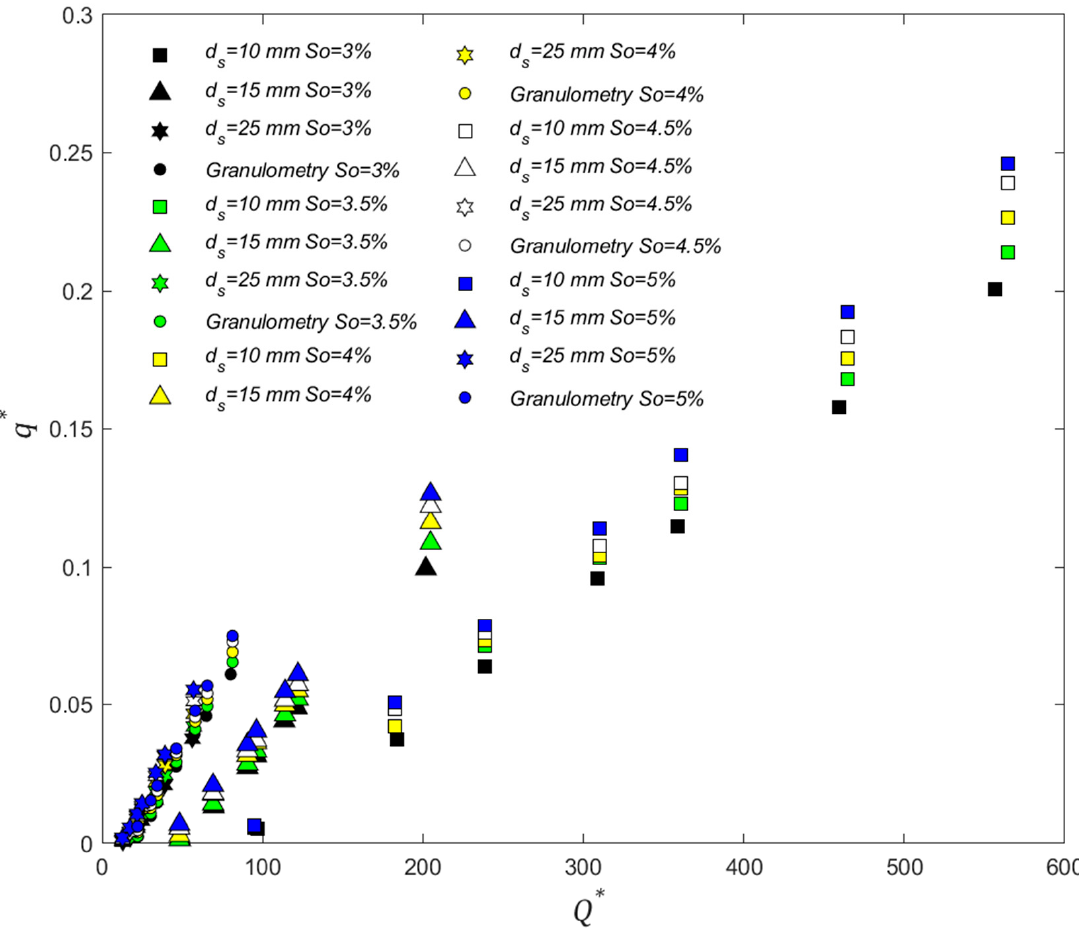
Figure 8. Variation of dimensionless transport rates with dimensionless discharge, particle size ( d s ) and slope ( So ).